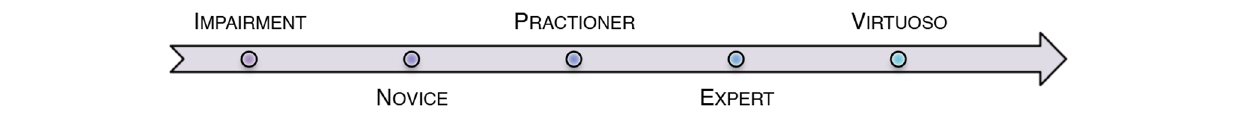
FIGURE 1 | Skill acquisition as a spectrum of complex hand dexterity.